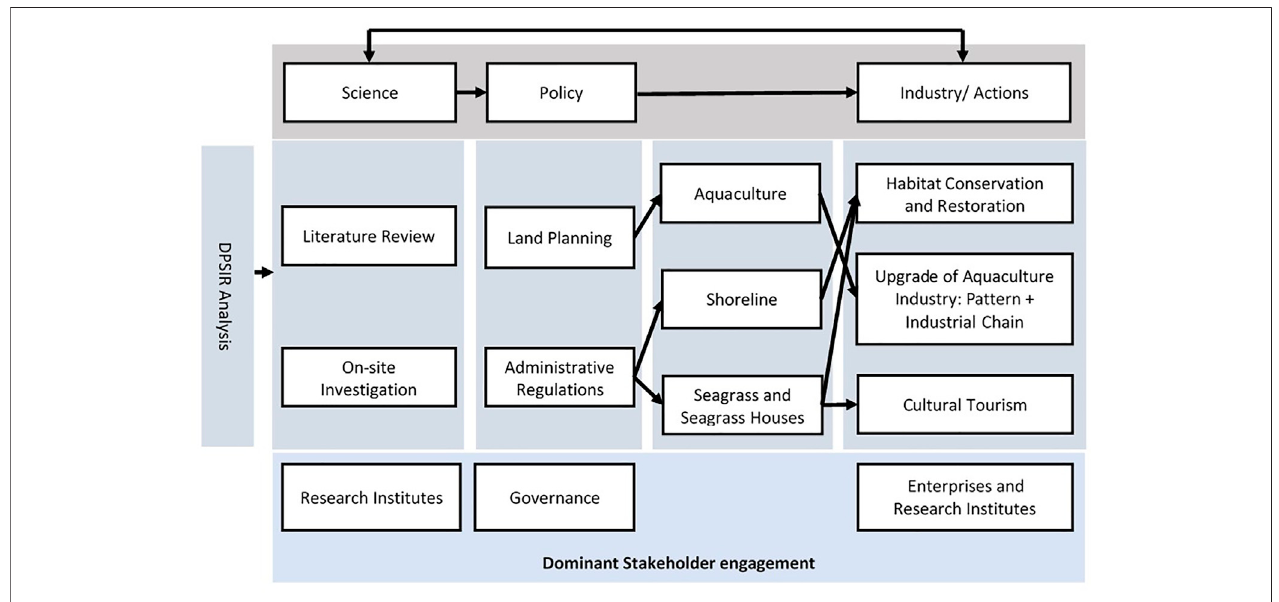
FIGURE 3 | Transdisciplinary, co-designed, adaptive management